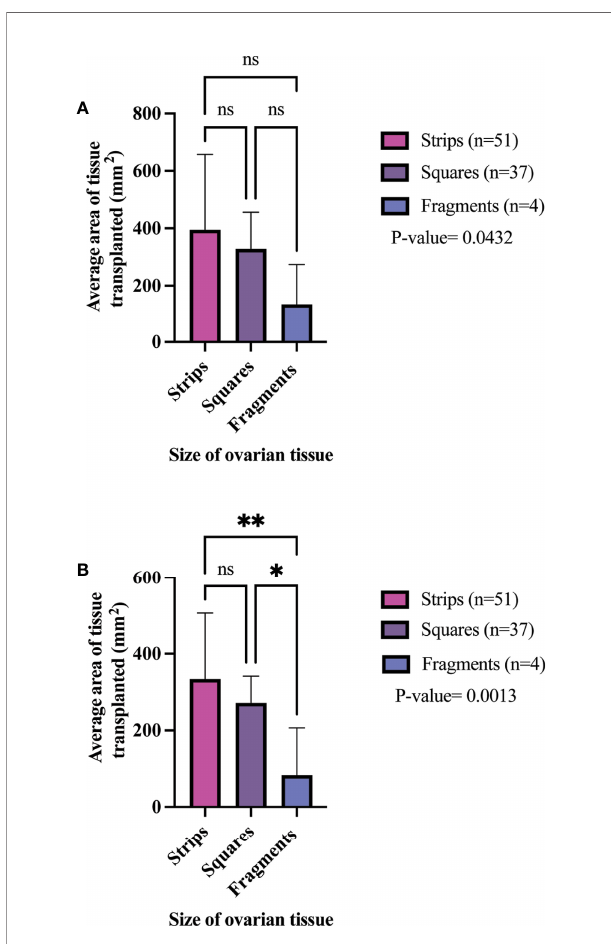
FIGURE 4 | Total average area of tissue transplanted (A) and per 1 st OTT (B) in different size cryopreserved and transplanted ovarian tissue. P-values greater than 0.05 were considered not signi fi cantly different (ns) P-values greater than 0.05 were considered not signi fi cantly different (ns).P-values less than 0.05 (*) and 0.005(**) were considered signi fi cantly different. (21, 22, 25, 34, 37, 44, 57, 59, 61, 64, 66, 78, 84, 91 – 93, 95, 111, 115, 118,